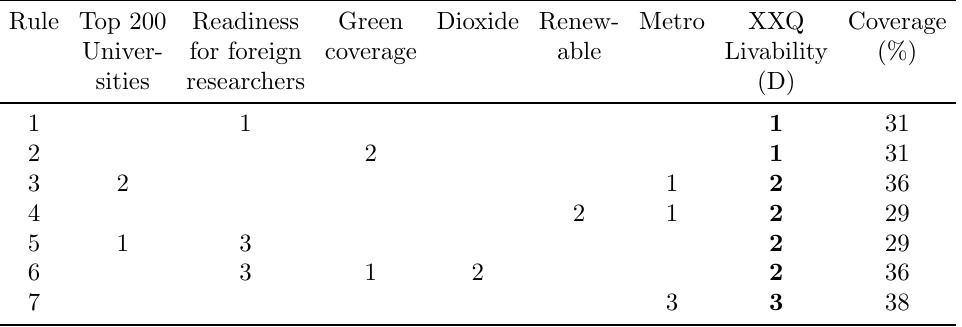
Table 8: Rough set rules explaining XXQ Livability by the most important single sub- factors Rule Top 200 Readiness Green Dioxide Renew- Metro XXQ Coverage Univer- for foreign